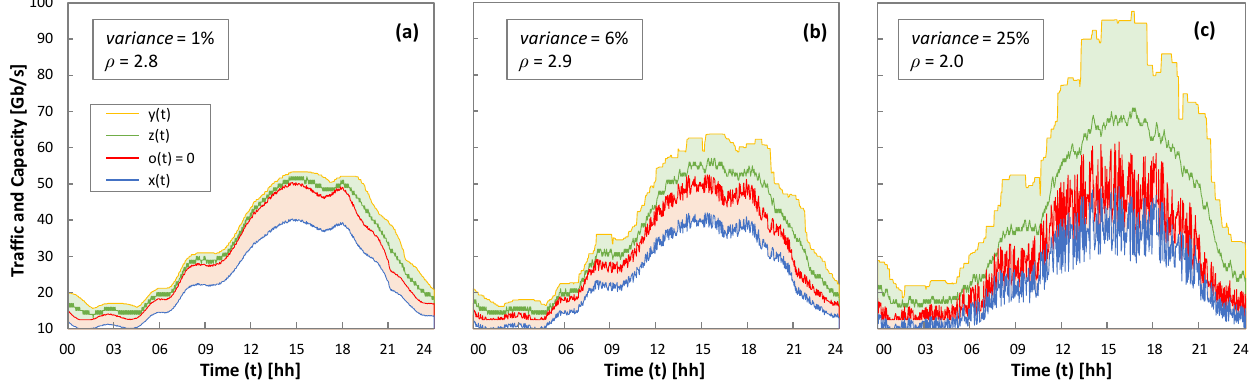
Figure 9. Q-Learning operation. Traffic and allocated capacity for low ( a ), moderated ( b ), and high ( c ) traffic variance.